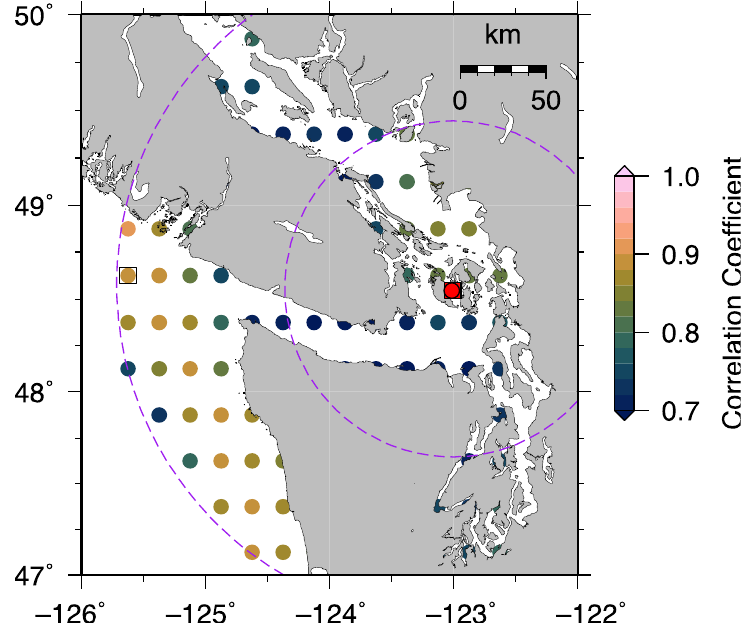
Figure A7. Correlation coefficient at SC02. The filled red circle represents the tide gauge while the open square represents the GNSS station. The colored dot with a black square is the grid point from which the de-seasoned and de-trended satellite altimeter data has the highest correlation coefficient with those from the coastal GNSS.